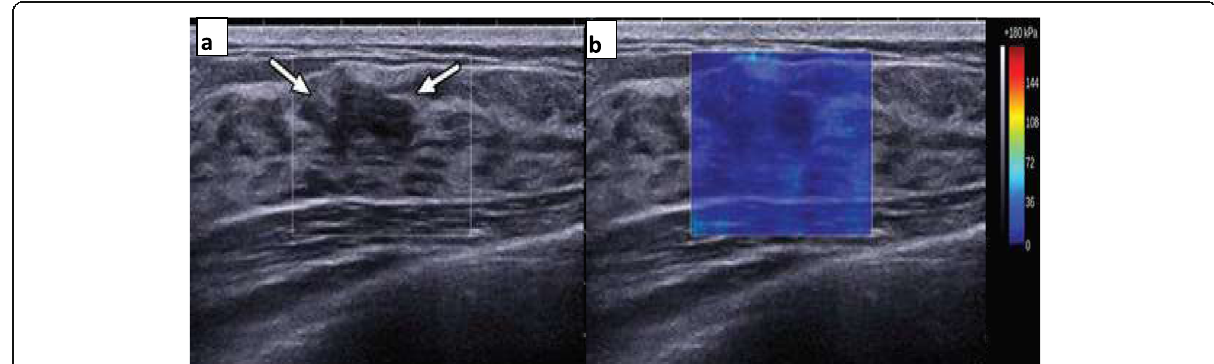
Fig. 2 A 38-year-old woman with Lt. breast mass proved to be fibroadenoma on histopathological examination. Left , B-mode ultrasound showed an ill-defined hypoechoic mass was seen at 7 o ’ clock location, which considered to be BIRADS 4b category (arrows). Right , shear-wave elastography of the